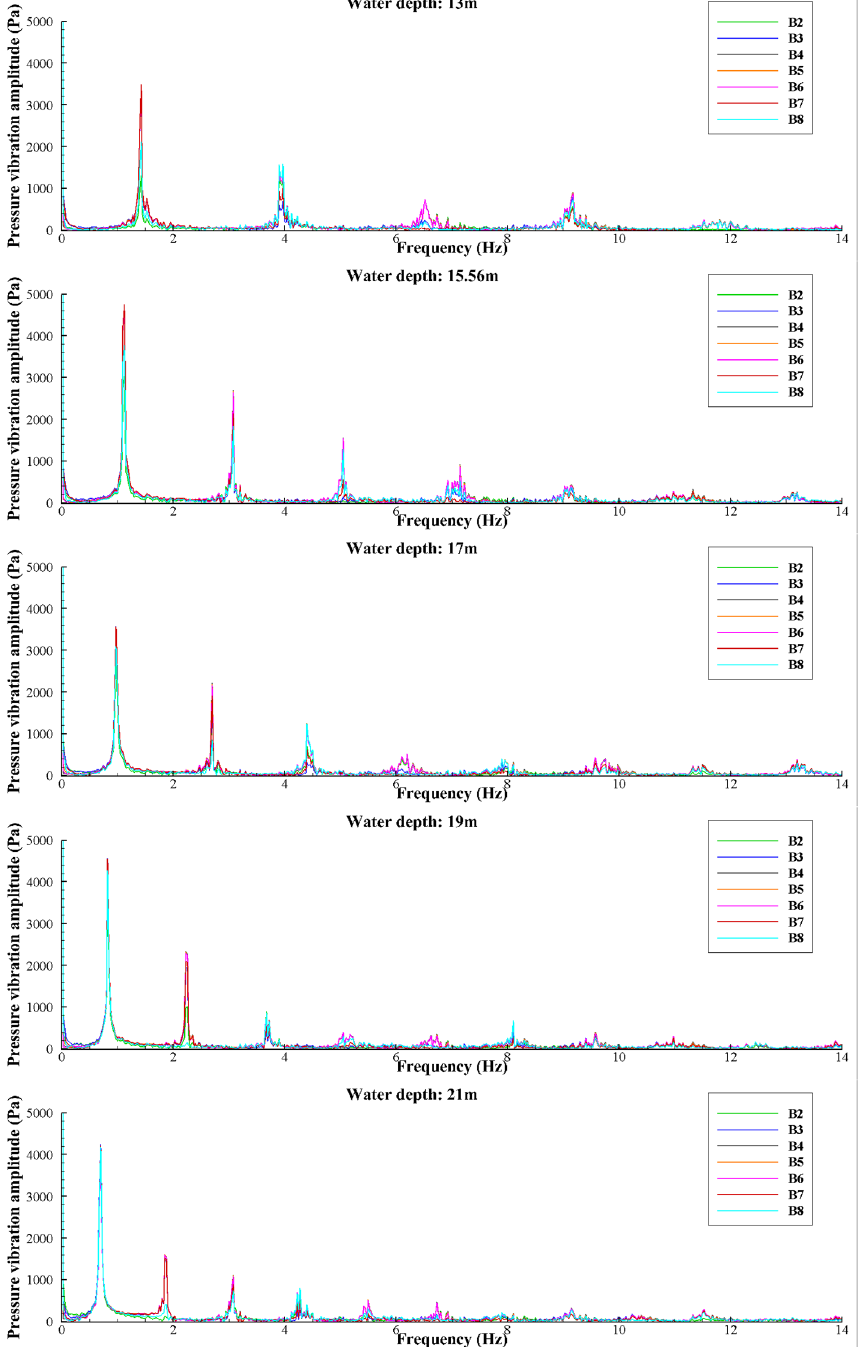
Figure 17. The fast Fourier transform (FFT) of pressure time − series at the monitoring boundary points for Wenchuan seismic excitation at different water